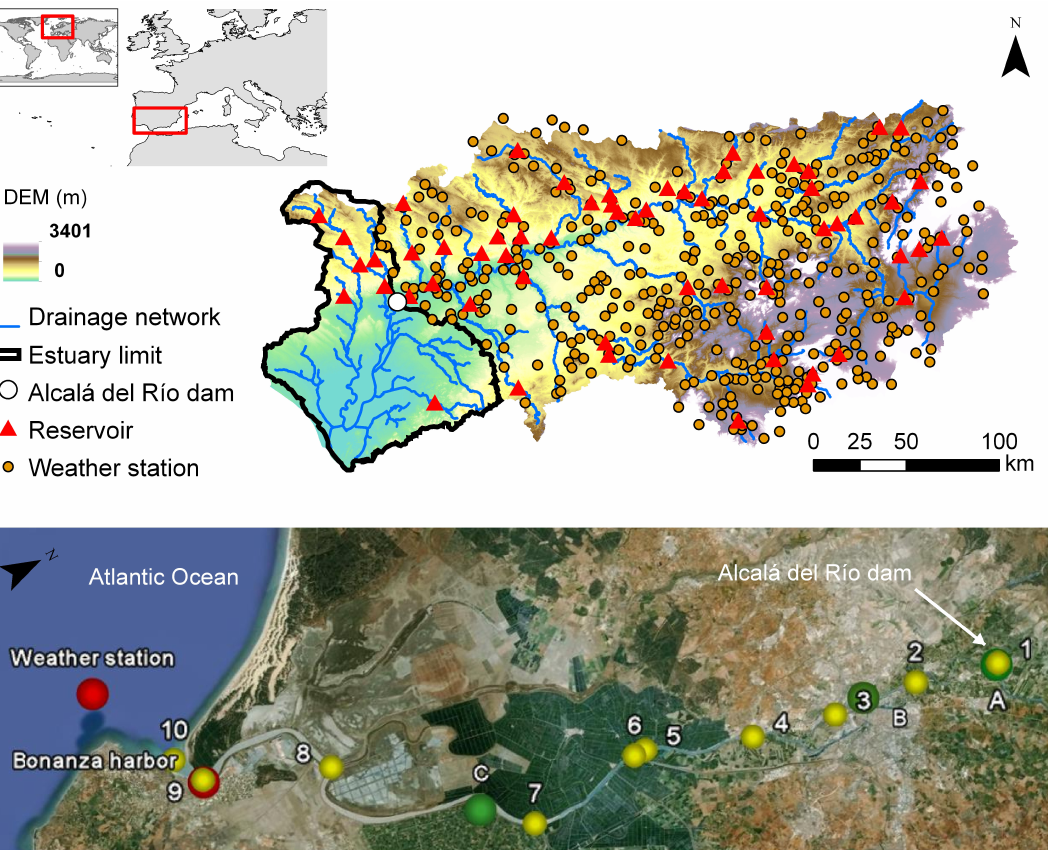
Fig. 1. Location of the Guadalquivir basin and estuary, reservoirs, Alcal´a del R´ıo dam and weather stations upstream, and water quality, fluvial and maritime stations in the